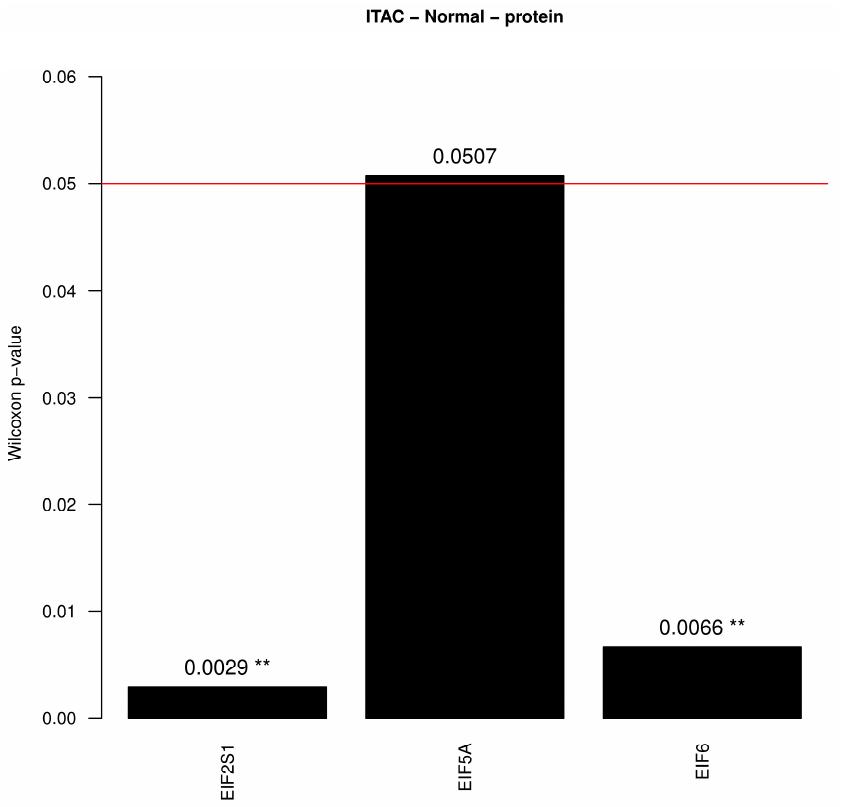
Figure 3. Significant Wilcoxon p -values of the translation factors ( p < 0.05) between the groups ITAC and NNT in TMA samples. Black bars and uppercase letters indicate that the arithmetic mean of the scores of the first group (ITAC) was higher than the arithmetic mean of the scores of the second group (NNT) and white bars and lowercase letters indicate the opposite. ** indicates a p -value < 0.01. The horizontal red line marks the threshold of 0.05. Based on the scores, Spearman’s rho was calculated using the R function ‘cor’ and additionally ‘cor-test’ to obtain the p -value. Additionally the groups ‘longer RecMet-shorter RecMet’ and ‘RecMet gene upper- RecMet gene lower’ were built. The median was used as cut-off. The values of each translation factor were compared against the values of the same translation factor from other categories using the R function wilcox.test to calculate the Wilcoxon p -value for a comparison of distribution differences. For each of the translation factors EIF2S1, EIF5A and EIF6, a χ 2 analysis was per- formed regarding locations, subtypes, stages and radiotherapy whereas scores of 0 to 8